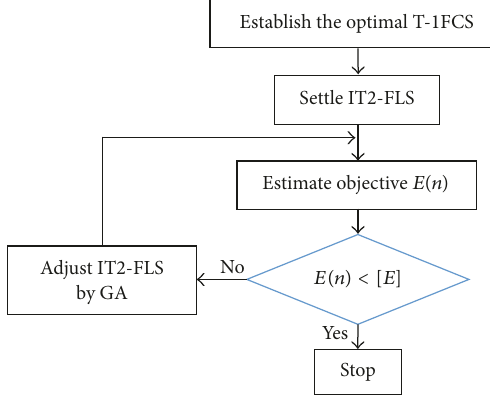
Figure 2: The flowchart of the algorithm